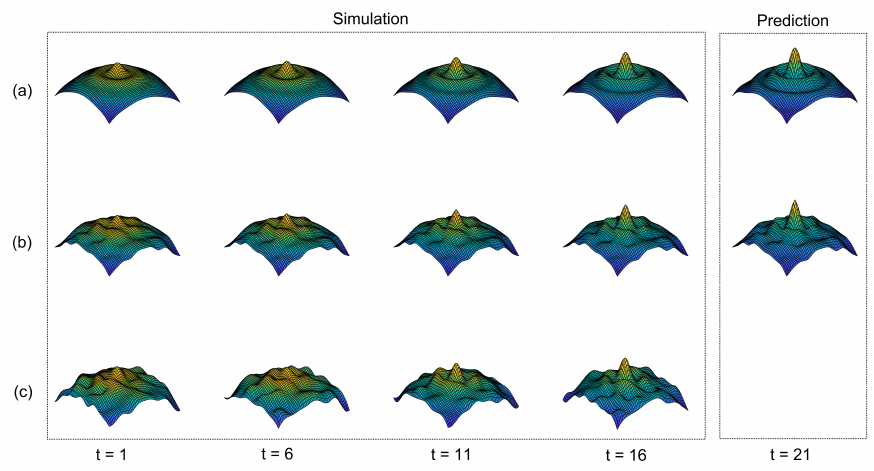
Figure 7. 2D sequence signal simulation (times 1, 6, 11, 16 and 21 are shown). ( a ) Original signal functions without white noise; ( b ) Fit by FUKSS; and ( c ) Fit by Smoothing thin-plate